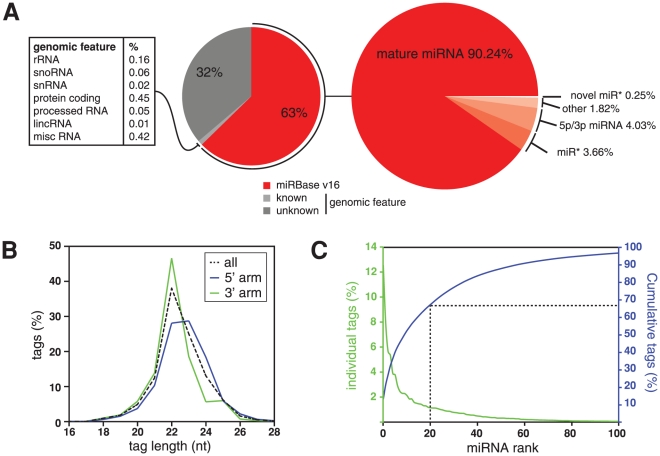
Identification of HL-1 cardiomyocyte miRNAs by next generation sequencing.(A) Distribution of 66,405,108 mappable small RNA sequence tags derived from HL-1 cells across miRBase version 16 and the mm37 mouse genome assembly (on left). Split of miRBase-mapped tags across different miRNA annotations (on right). (B) Distribution of tag lengths for all generic miRBase-mapped tags (dashed line), or separately for those derived from the 5′ or 3′ arm of precursor hairpins (blue and green lines, respectively). (C) Distribution of tag counts across the one hundred most abundant miRNAs. Contribution of individual miRNAs to total tag count (green), or cumulative tag contribution (blue) is plotted against ranked miRNA abundance.